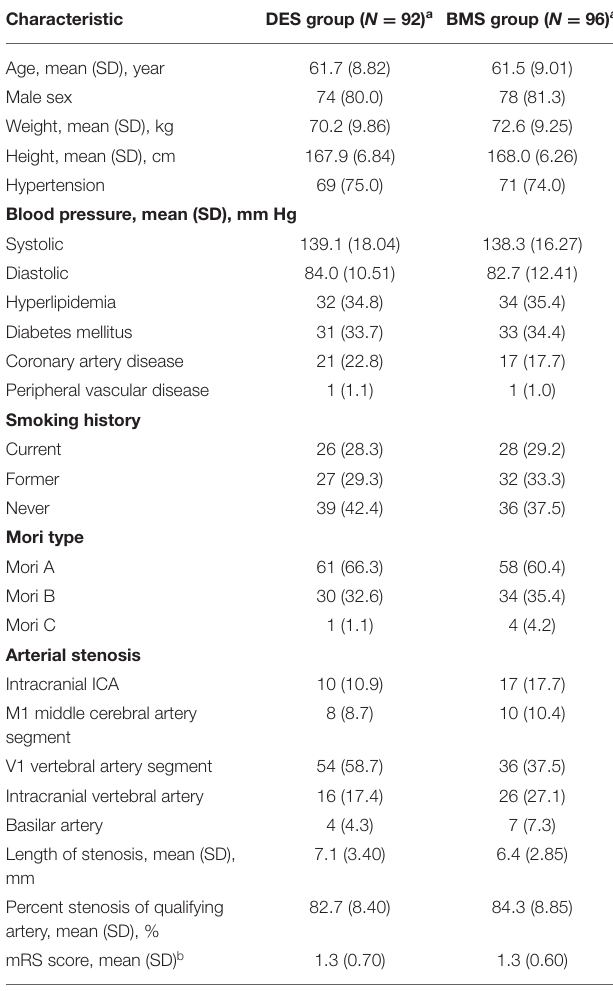
TABLE 1 | The baseline characteristics of the 188